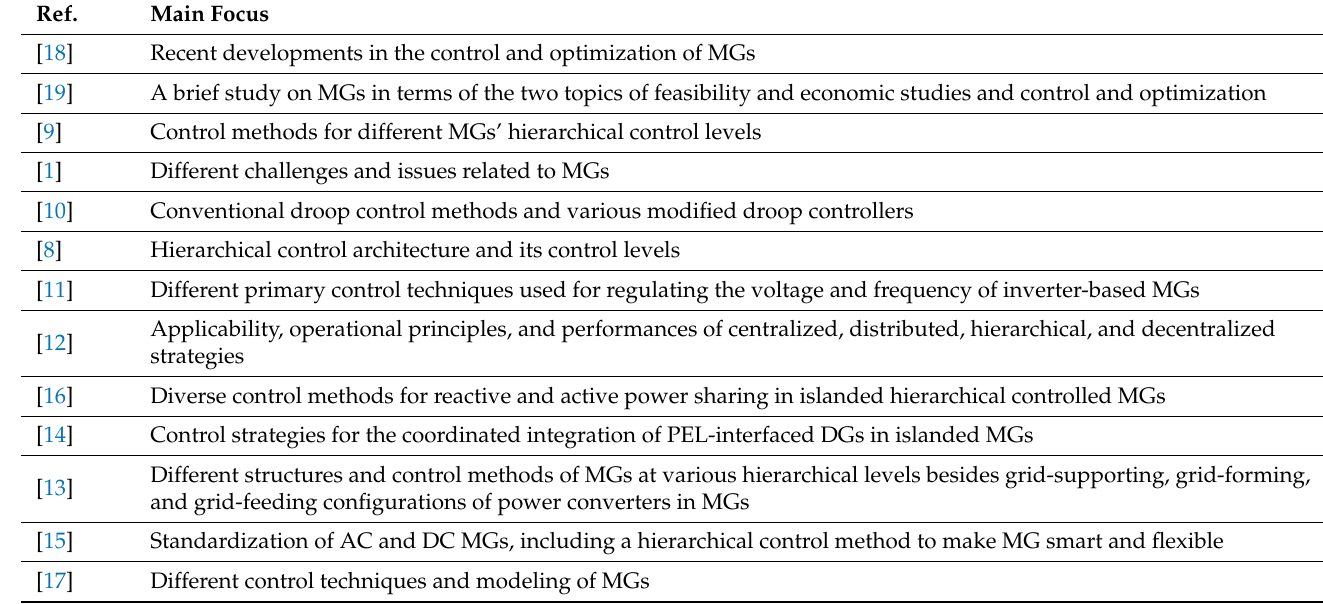
Table 1. Different review papers on the microgrid control